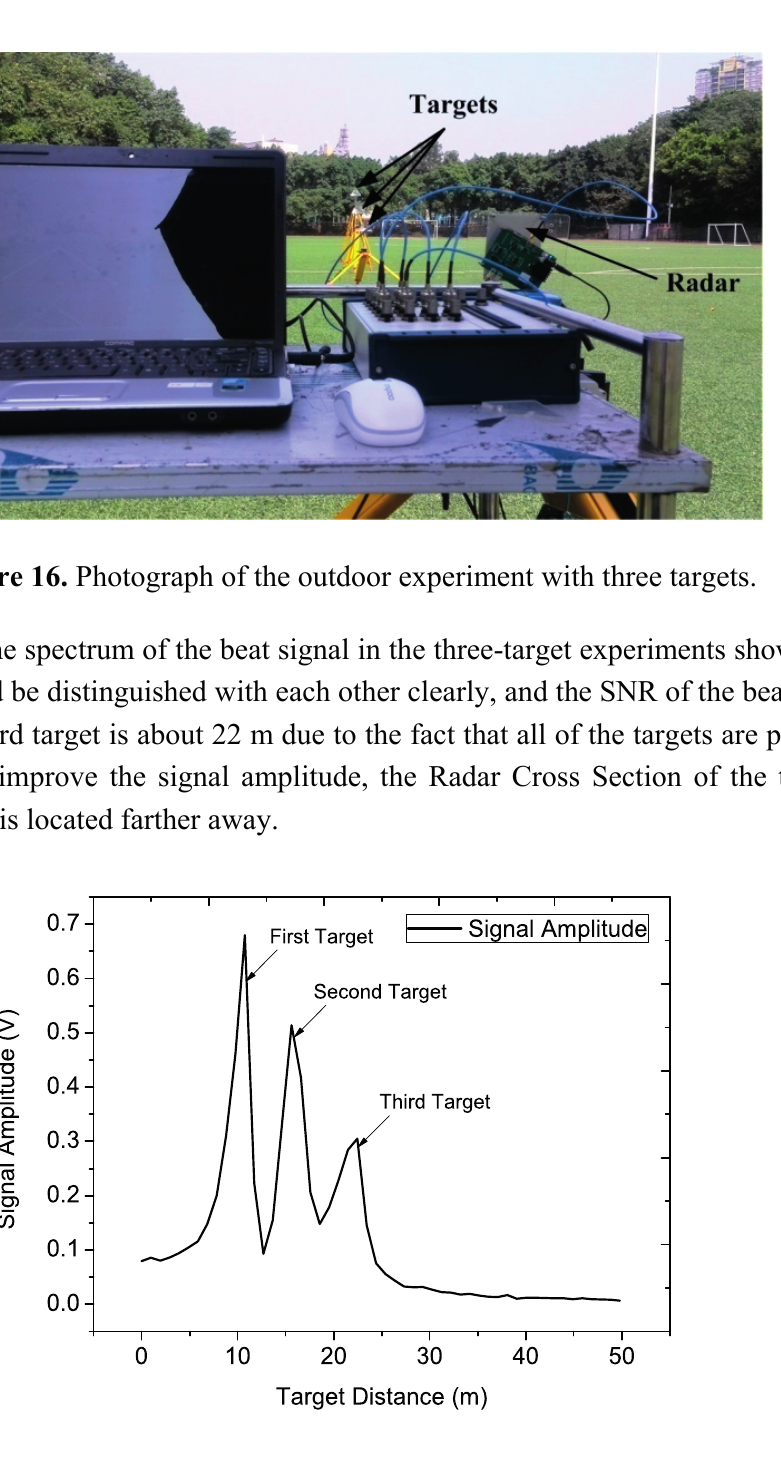
Figure 17. Spectrum of the beat signal in the three targets